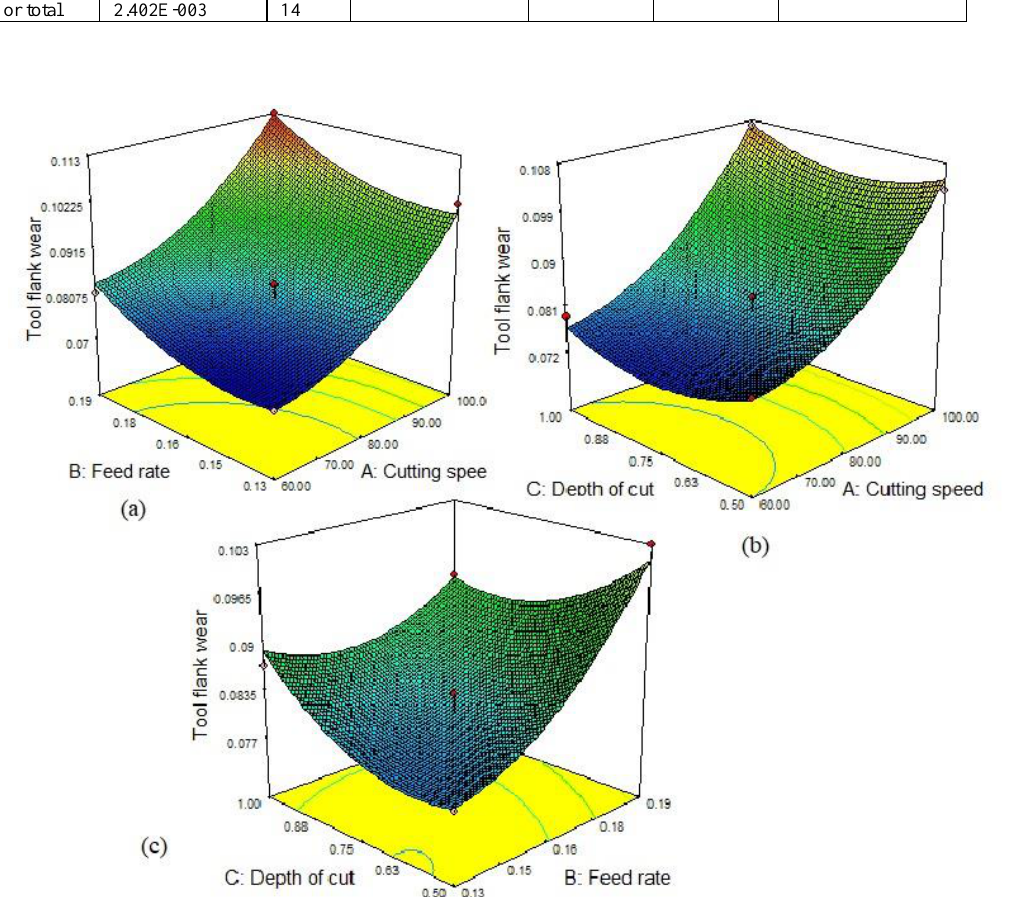
Figure 9. (a-c). Esteemed response surface plot for tool flank